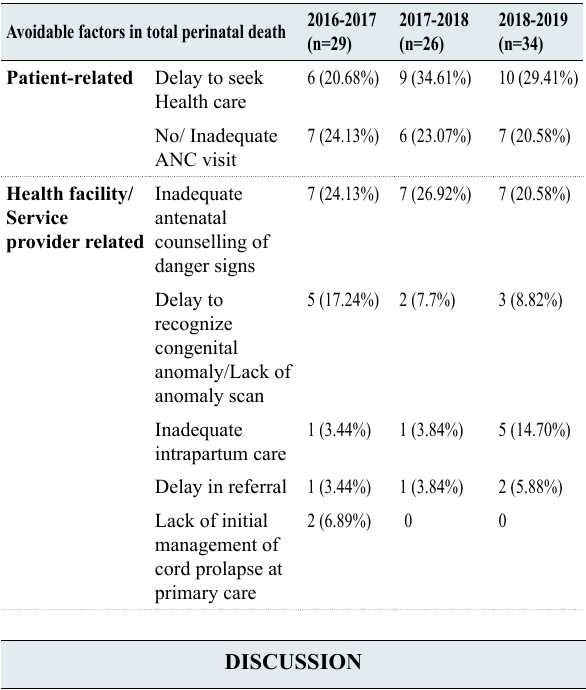
Table 4. Comparison of avoidable factors in perinatal deaths over three